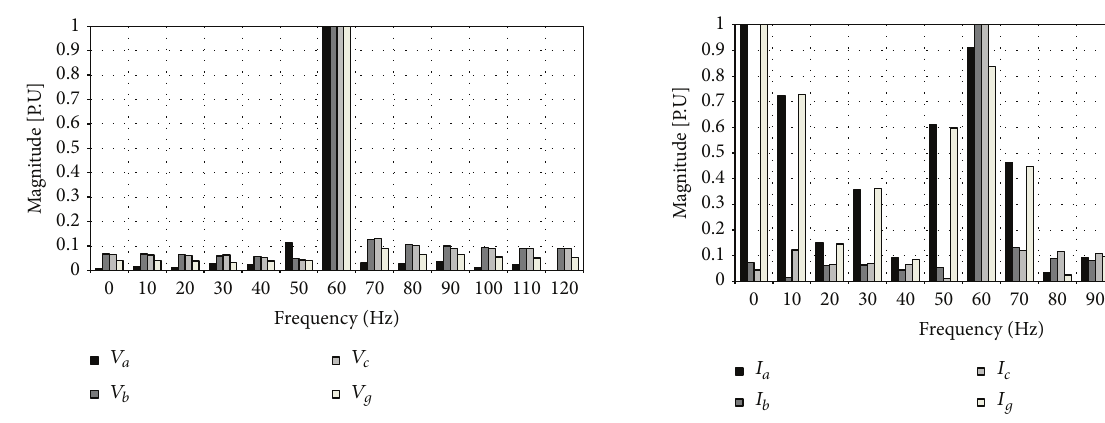
each grouping, the same as the first one, represent the type of fault, which they refer to in a binary way.